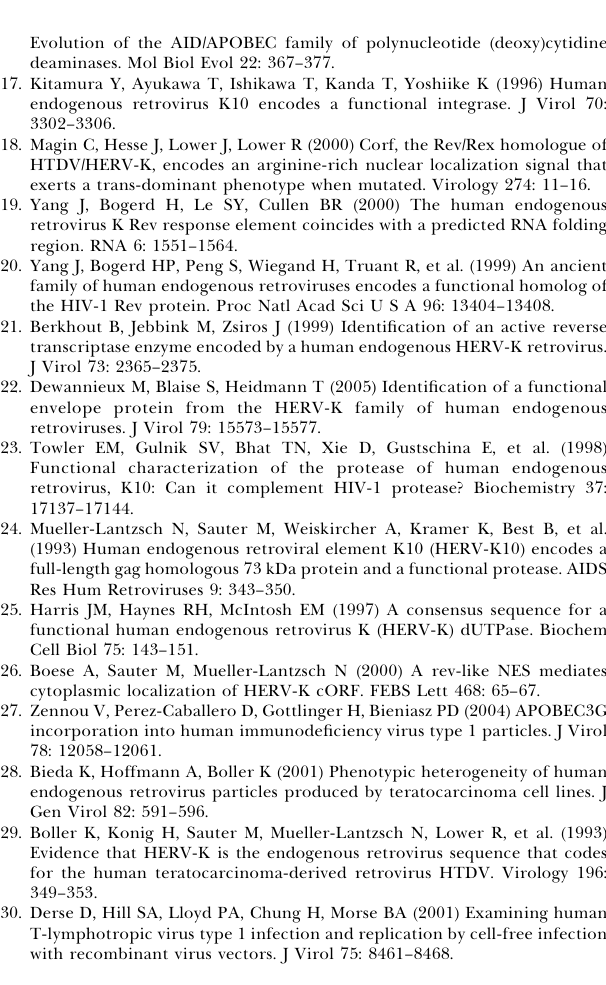
Figure S1. HERV-K CON Proviral Sequence The complete 9,472-nucleotide provial sequence is shown. LTR sequences are underlined. Protein sequences encoded by Gag, PR, Pol, Env, and K-Rev ORFs are also